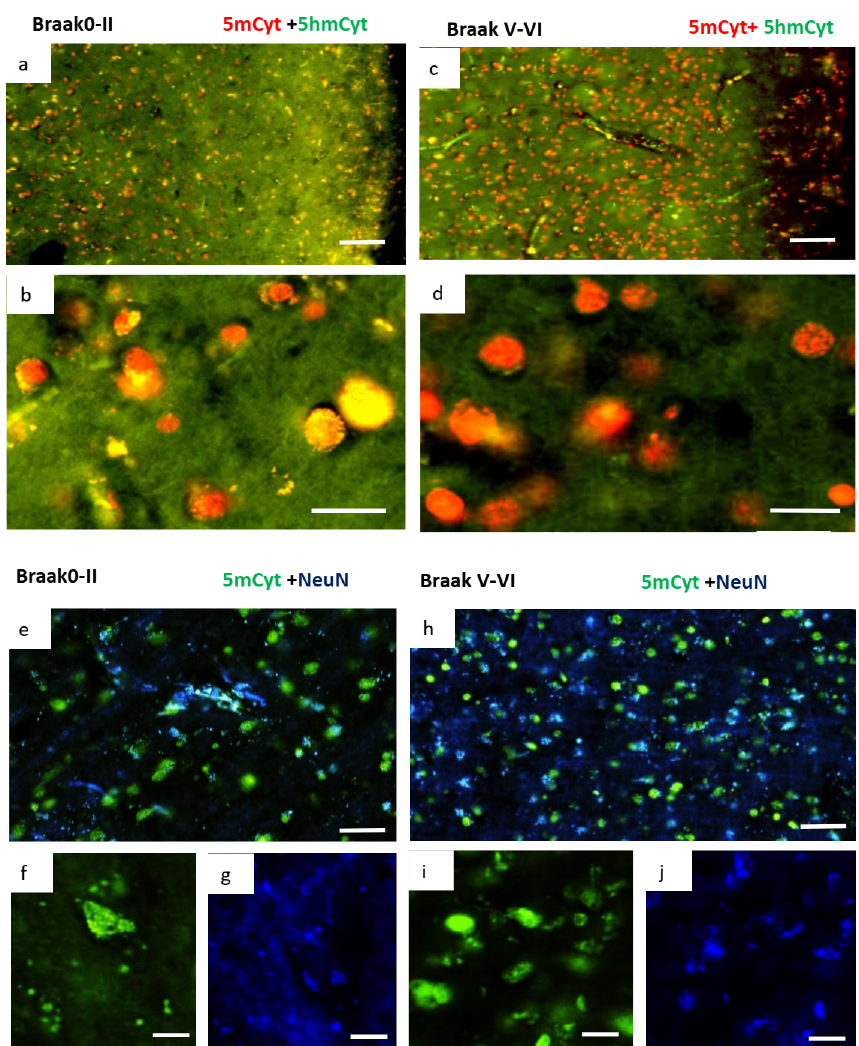
Figure 7. Immunofluorescence staining for 5-methyl cytosine (5mc, marker of methylation) and 5-hydroxy methyl cytosine (5hmc, marker of demethylation) in neurologically normal (Braak 0- II) and AD (Braak V-VI) brains. Double immunofluorescence staining for 5-methyl cytosine (red) and 5-hydroxy methyl cytosine (green) in normal cortical cells (( a ) at 100 × , scale: 100 µ m and ( b ) 400 × , scale: 20 µ m) show a balance of methylation and demethylation (seen as colocalised, yellow staining). In AD brain (( c ) at 100 × , scale: 100 µ m and ( d ) 400 × , scale: 20 µ m) cells show almost exclusive methylation with very little demethylation. Double immunofluorescence staining for 5mc (green) and the neuronal marker NeuN (blue) in normal ( e ) and AD ( h ) are also shown in separated channels ( f , g , i , j ) to show that many cells have colocalised with many more in AD brain, indicating hypermethylation of neurones in AD. ( e , h ), at 100 × , scale: 100 µ m. ( f – j ) at 200 × , scale: 50 µ m. The figure is representative of neurologically normal n = 3 and AD n = 4